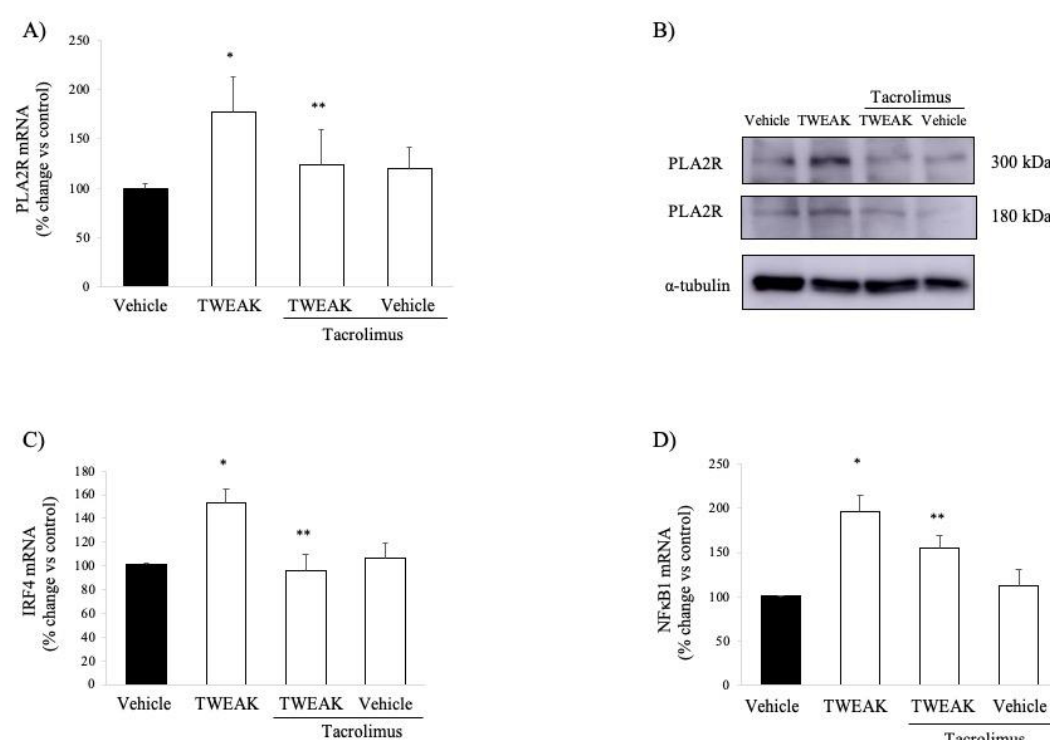
Figure 4. TWEAK increases PLA2R expression in cultured human podocytes: impact of tacrolimus. ( A , B ) TWEAK 100 ng / mL increases PLA2R mRNA ( A ) and protein ( B ) expression in cultured human podocytes after 6 h. This was prevented by pretreatment with 25 ng / mL tacrolimus. Real time RT-PCR and representative Western blot. Two main bands were detected in Western blot, likely representing the full-length and extracellular domain of this glycosylated protein that may be generated by alternative splicing or proteolytic processing. Mean ± SD of three independent experiments. * p < 0.05 vs. Vehicle, ** p < 0.05 vs. TWEAK alone. Complete gel shown in Supplementary Figure S2. ( C , D ) TWEAK also increased the mRNA levels of IRF4 ( C ) and NFKB1 ( D ) assessed by quantitative RT-PCR. This was also prevented by tacrolimus. * p < 0.02 vs. vehicle; ** p < 0.02 vs. TWEAK alone.